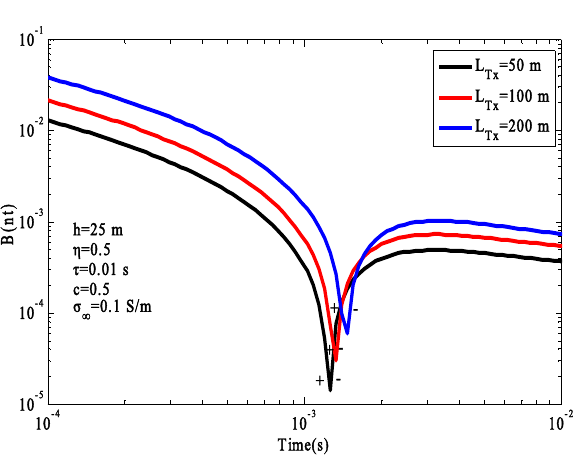
ff erent emission source lengths. Appl. Sci. 2020 , 10 , 1027